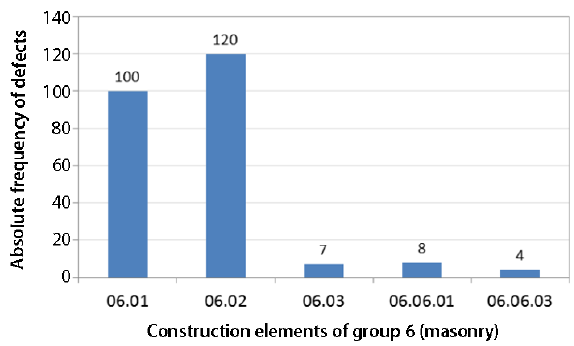
Fig. 17. Absolute frequency of the specific causes of anomalies in masonry (06) belonging to the general groups C1, C2 and